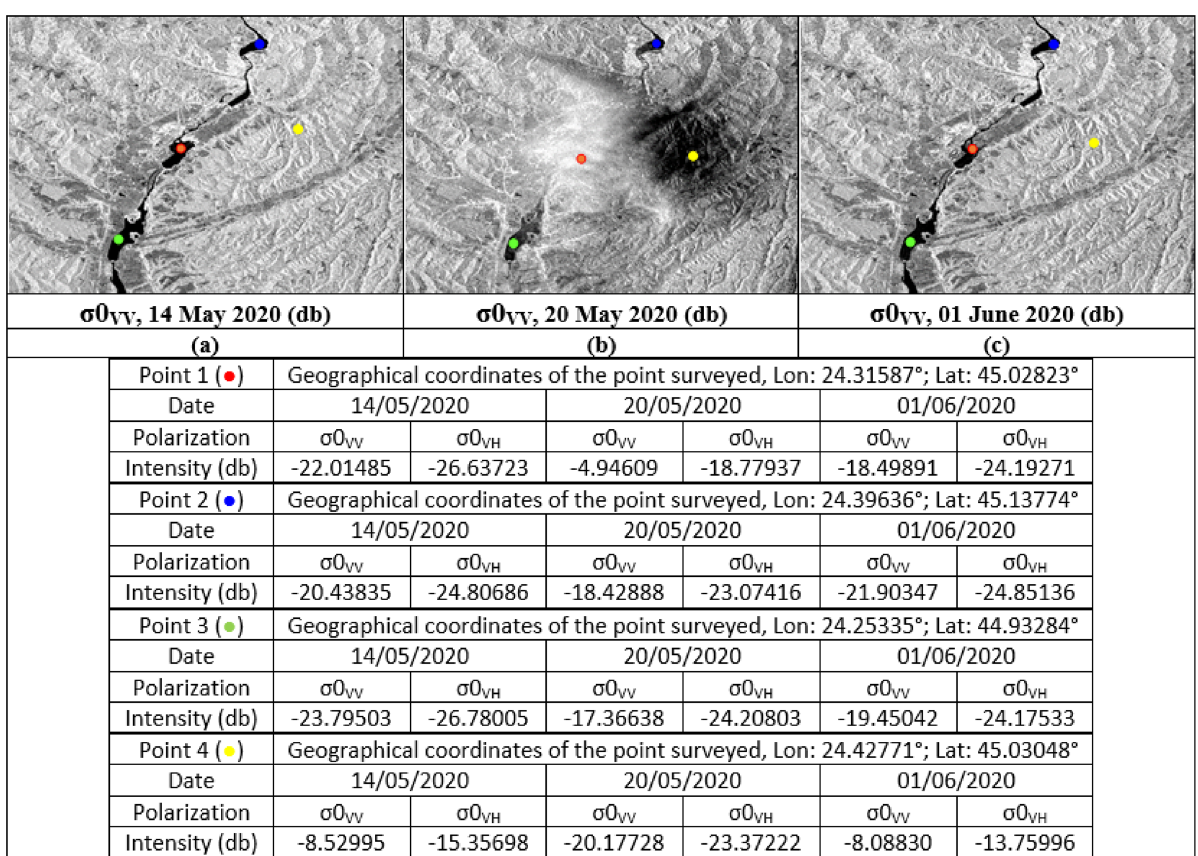
reference images used and n: corresponds to the numbers of the reference images used.